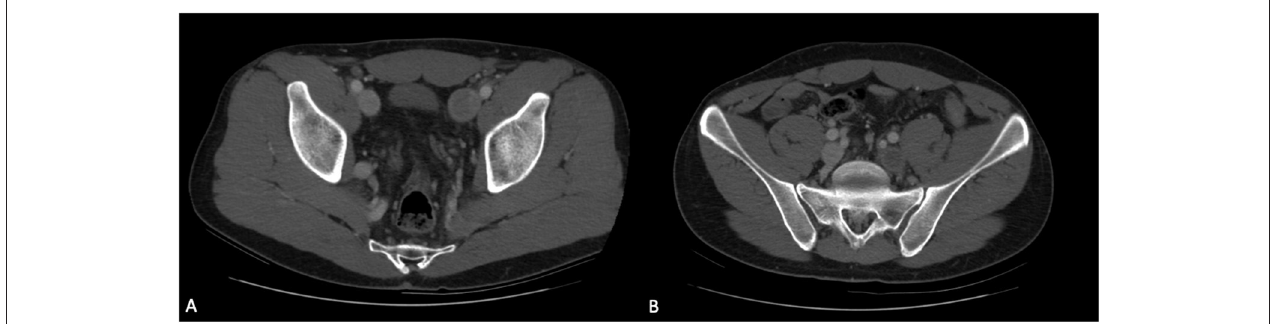
FIGURE 1 | (A,B) Patient’s CT-angiography at admission revealing complete thrombosis of left external iliac vein, right internal iliac vein, and partial thrombosis of right external iliac